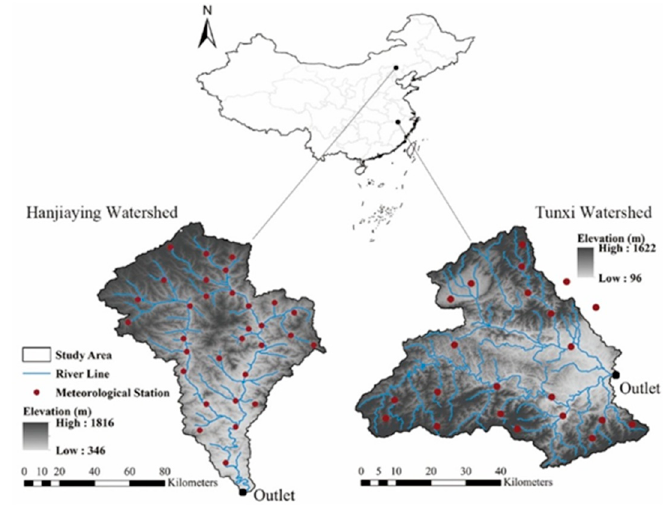
Figure 1. Location and elevation of the Hanjiaying and Tunxi watersheds.